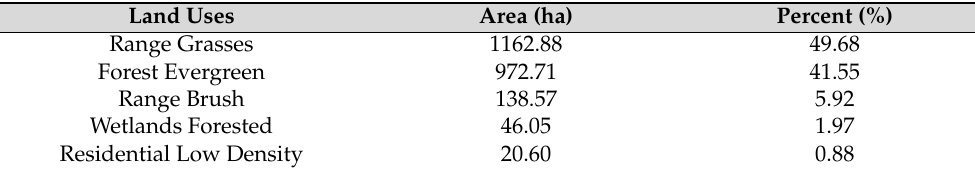
Table 2. Land use of the Pago Watershed.